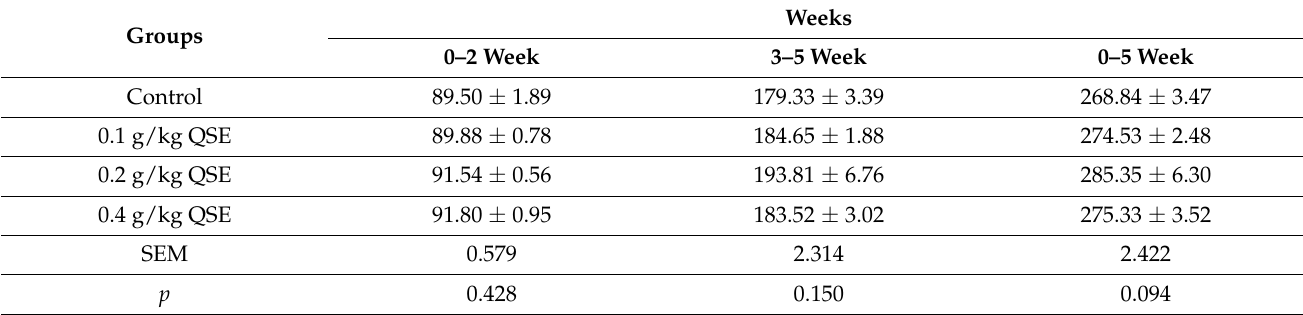
Table 3. Body weight gains of experimental groups (g).